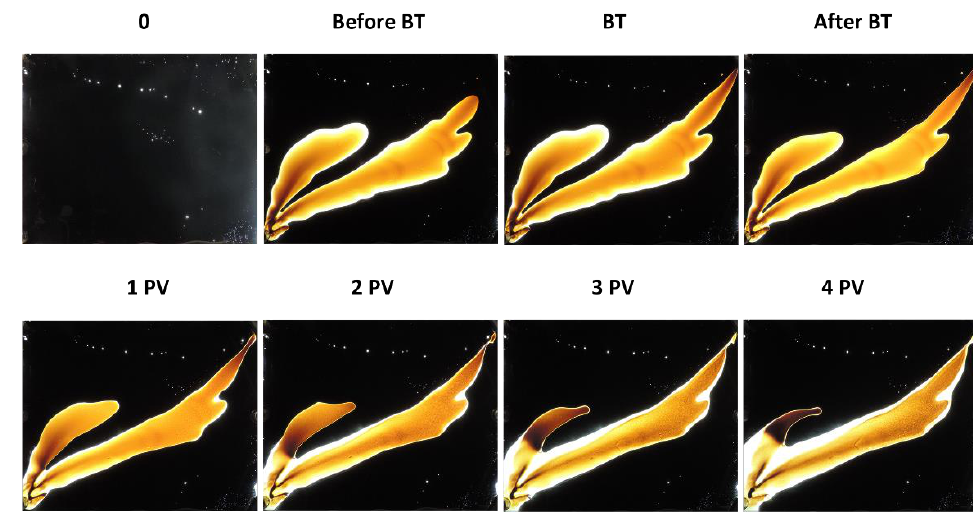
Figure 6. Crude oil displacement by waterflooding at 0.3 mL/min.